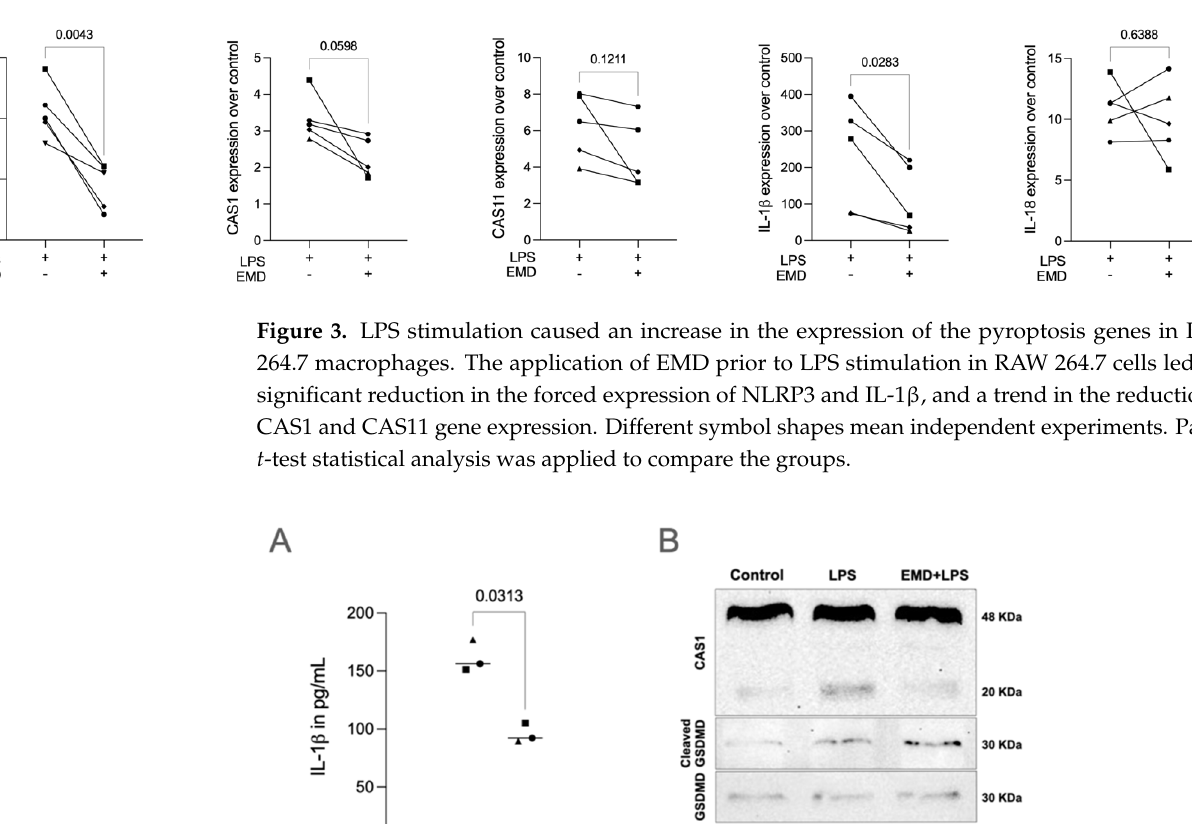
Figure 3. LPS stimulation caused an increase in the expression of the pyroptosis genes in RAW 264.7 macrophages. The application of EMD prior to LPS stimulation in RAW 264.7 cells led to a signifi- cant reduction in the forced expression of NLRP3 and IL-1 β , and a trend in the reduction of CAS1 and CAS11 gene expression. Different symbol shapes mean independent experiments. Paired t -test statistical analysis was applied to compare the groups.